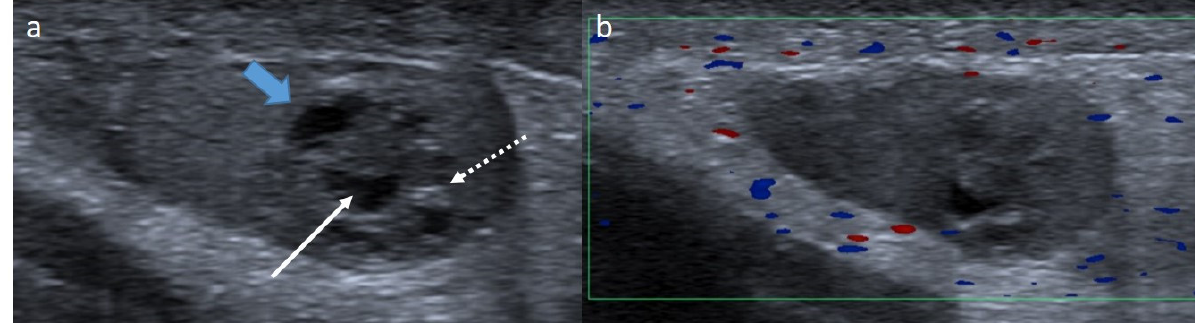
Figure 7. Granulosa-cell tumor in a 1-month-old boy. Longitudinal gray-scale B mode ( a ) and color Doppler ( b ) US of the testis. Images show a well-circumscribed mass with lobulated margins (blue arrow) containing a cystic component (arrow) and calcifications (dotted arrow). Serum levels of tumor markers were normal, and partial orchidectomy with an inguinal approach was performed. US, ultrasonography.